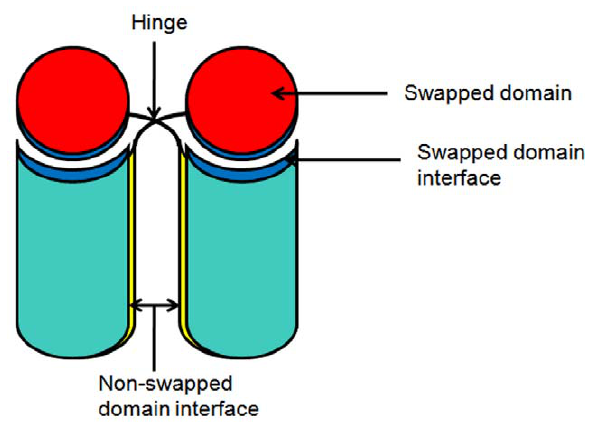
Figure 1. Domain-swapped oligomers with different regions ( Figure 1 ) forms after oligomerization between monomeric subunits. ‘Swapped domain interface’ (DSI) is intermolecular interface formed between swapped domain and rest of the portion of the protein. This interface is the energetically optimized interface during the course of evolution which gets utilized in the oligomeric form more than once [10]. This is the major advantage of domain-swapped oligomers over other oligomers. Mutation in this interface may induce domain-swapping in some proteins e.g.: NF- b p50 protein [11]. Eisenberg had shown that weakening of subunits. Oligomerization through domain-swapping highly de- pends upon the strength of interactions within this interface.